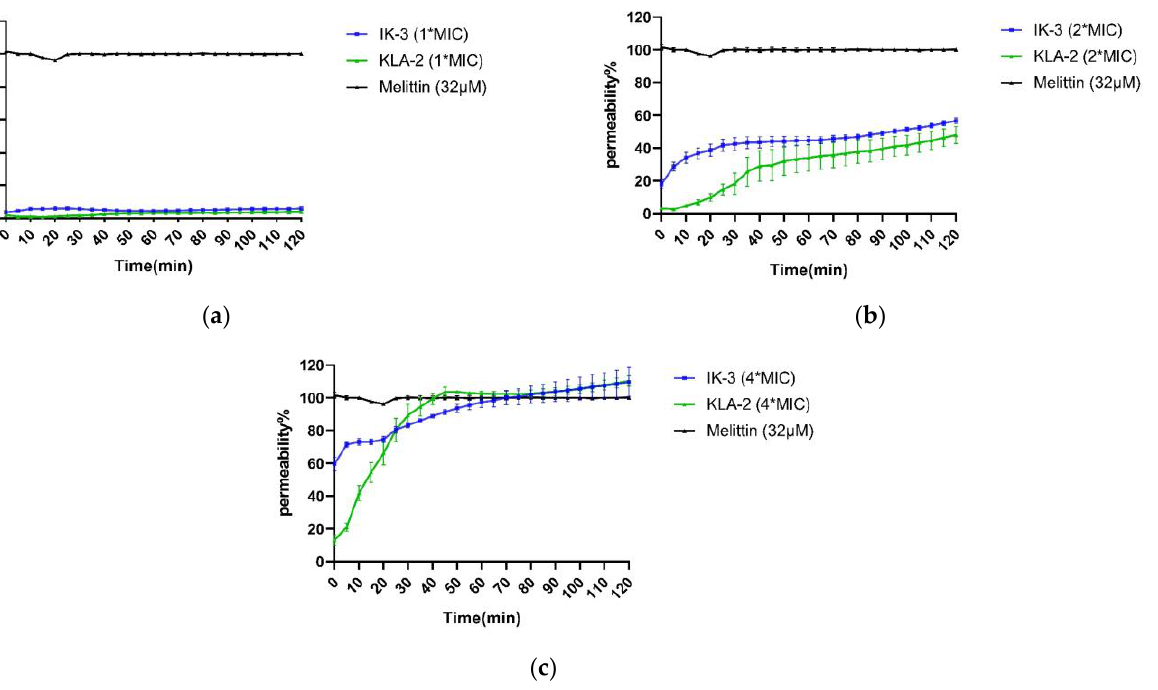
Figure 7. Permeability curves of IK-3, KLA-2, and melittin against E. coli (NCTC 8739) at ( a ) MIC, ( b ) 2-fold MIC, and ( c ) 4-fold MIC. The 100% membrane permeabilization was measured using bacteria treated with melittin (32 µ M).